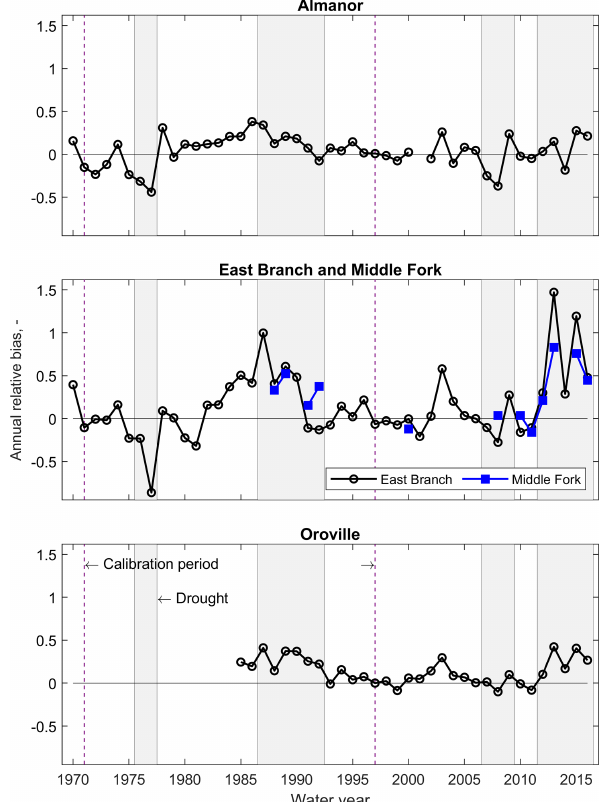
Figure 6. Annual relative bias for full-natural flow at the outlet of all (sub-)basins under study (difference between model and obser- vations of cumulative annual full-natural flow, relative to the